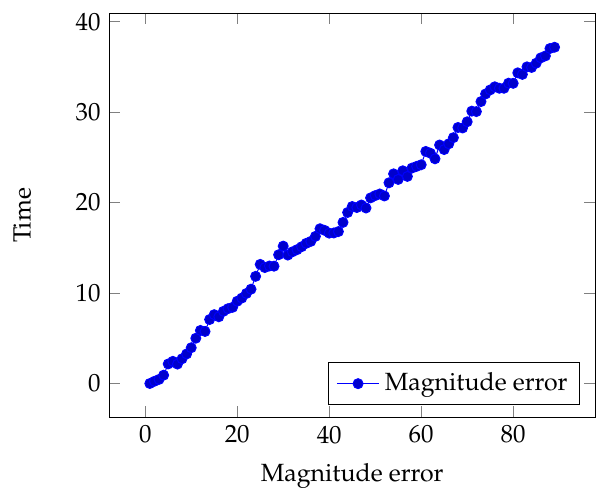
Figure 26. Data of 2D agents position estimation.